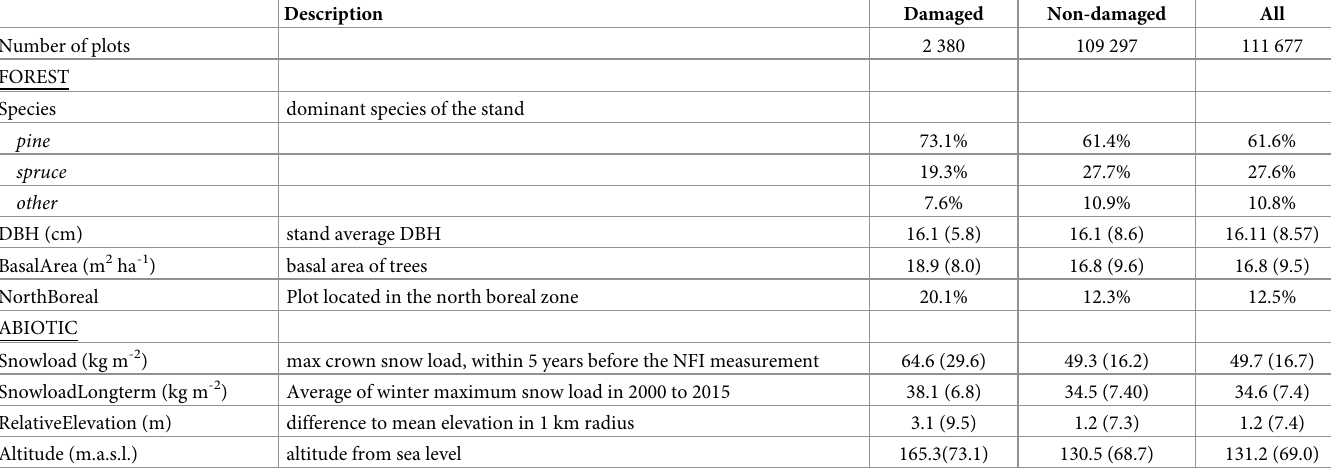
Table 2. Number of plots and the descriptive statistics for forest, topographical and snow load variables included in the final model for damaged and non-damaged plots separately and for all the plots in the data. Values for categorical variables show percentages of plots in each class. Values for continuous variables show mean and standard deviation, the latter in